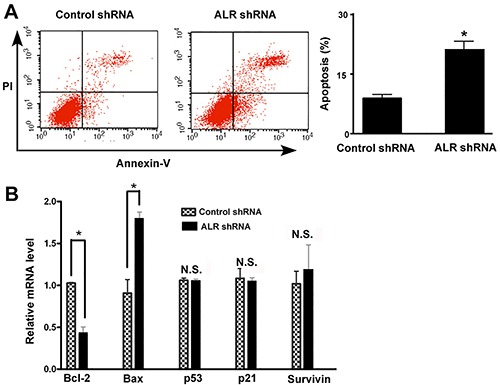
Augmenter of liver regeneration (ALR) silencing induced apoptosis in U266 multiple myeloma cells. A, Flow cytometric analysis of apoptosis in U266 cells transfected with control or ALR shRNA after Annexin-V/PI staining. B, qRT-PCR analysis of indicated transcripts in U266 cells transfected with control or ALR. *P<0.05 vs the control shRNA group; n=3. N.S. indicates no significance between the 2 groups (Student t-test).